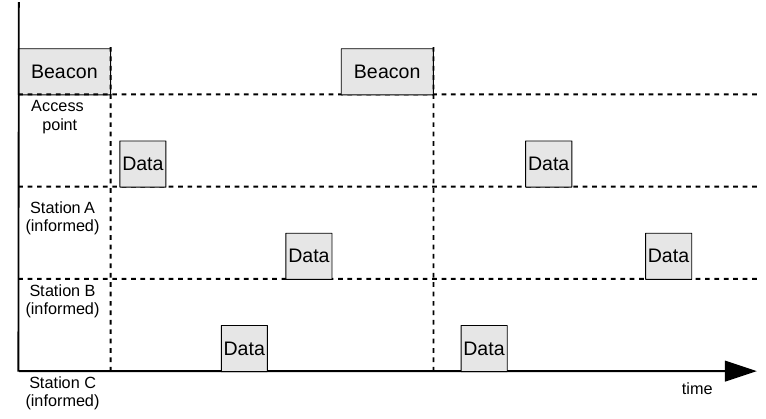
Figure 5. Variant of the SFO method with three informed stations.